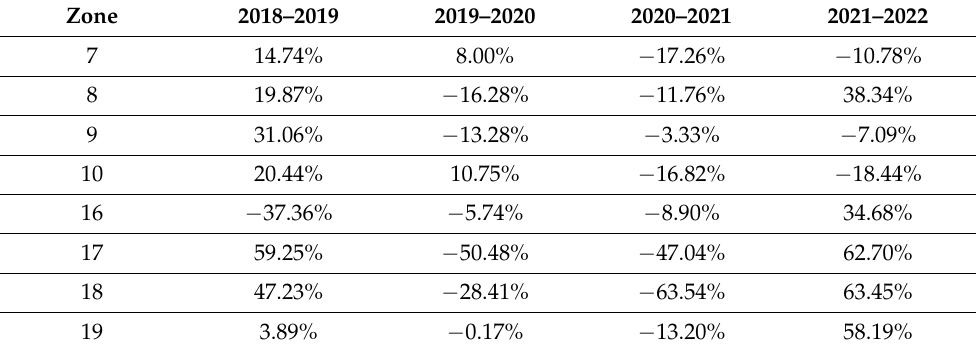
Table 5. Percent difference in biomass between years. Positive values indicate an increase in biomass from the previous year.